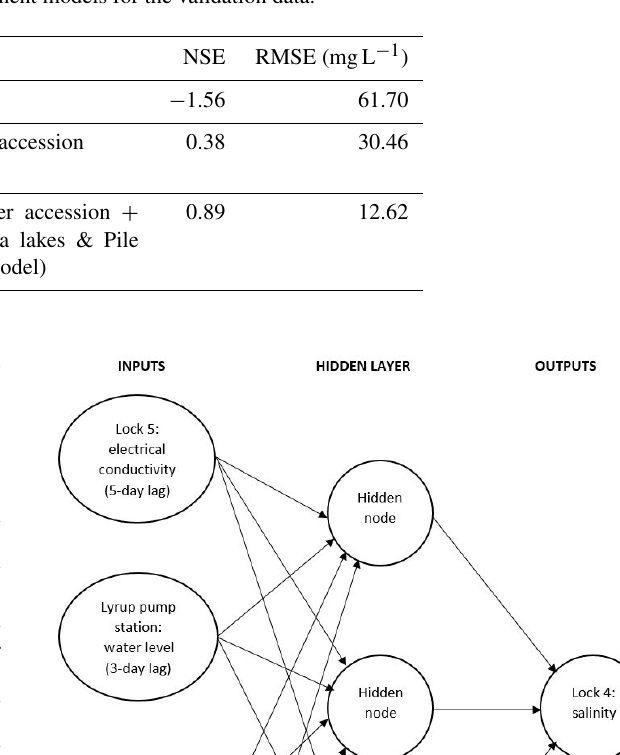
Table 4. Performance statistics for the hybrid model and its component models for the validation data.